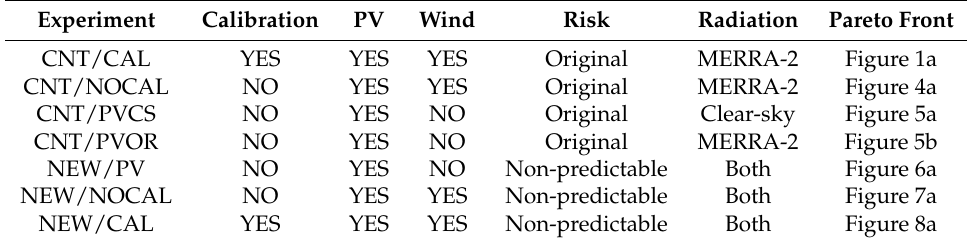
Table 1. List of experiments performed in this study. An additional NEW/UNIEFF experiment is discussed and based on the NEW/NOCAL with uniform efficiencies across regions. CNT and